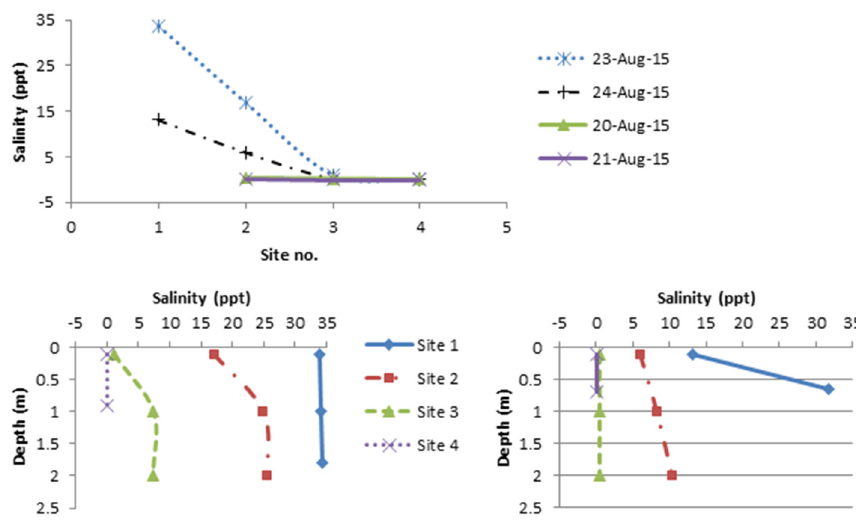
Figure 7. Top —Surface salinity profiles upstream from estuary mouth (sites 1–4), with Site 1 being at Figure 7. Top—Surface salinity profiles upstream from estuary mouth (sites 1-4), with Site 1 being the mouth. Bottom —Depth profile of salinity during flood tide (23 Aug-15—left) and (24 at the mouth. Bottom—Depth profile of salinity during flood tide (23 Aug-15—left) and (24 Aug- 15—right).